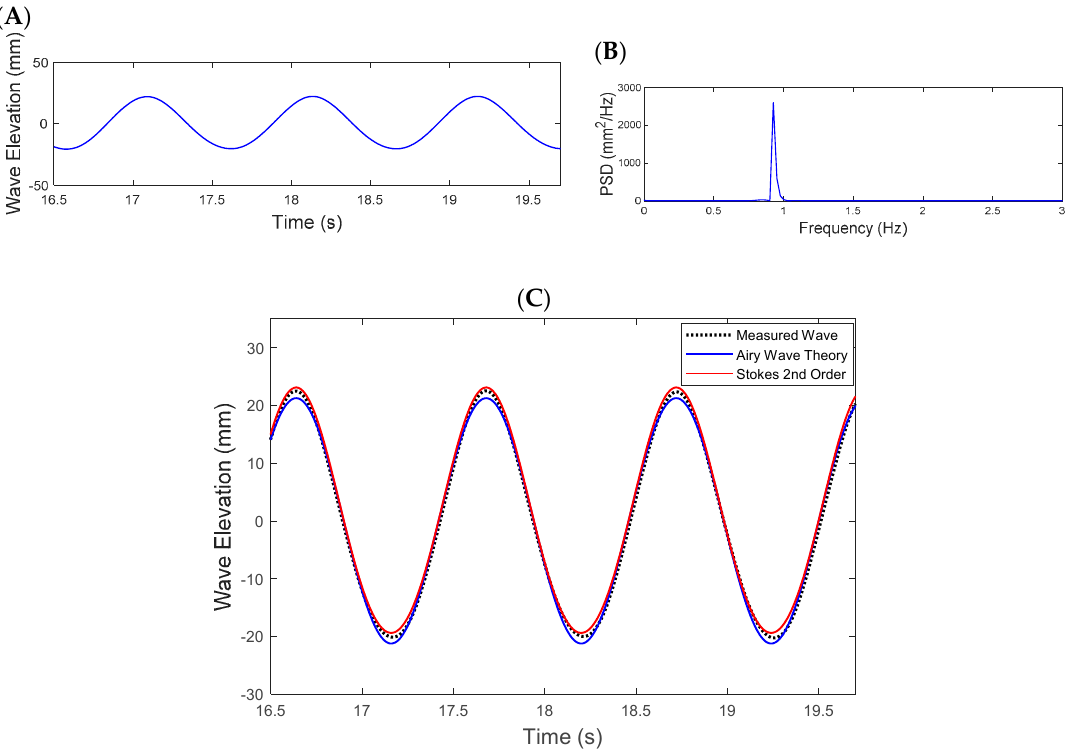
Figure 5. Measured wave elevation time history at WP2 ( A ), PSD for wave elevation time history ( B ) and comparisons with wave theory ( C ).